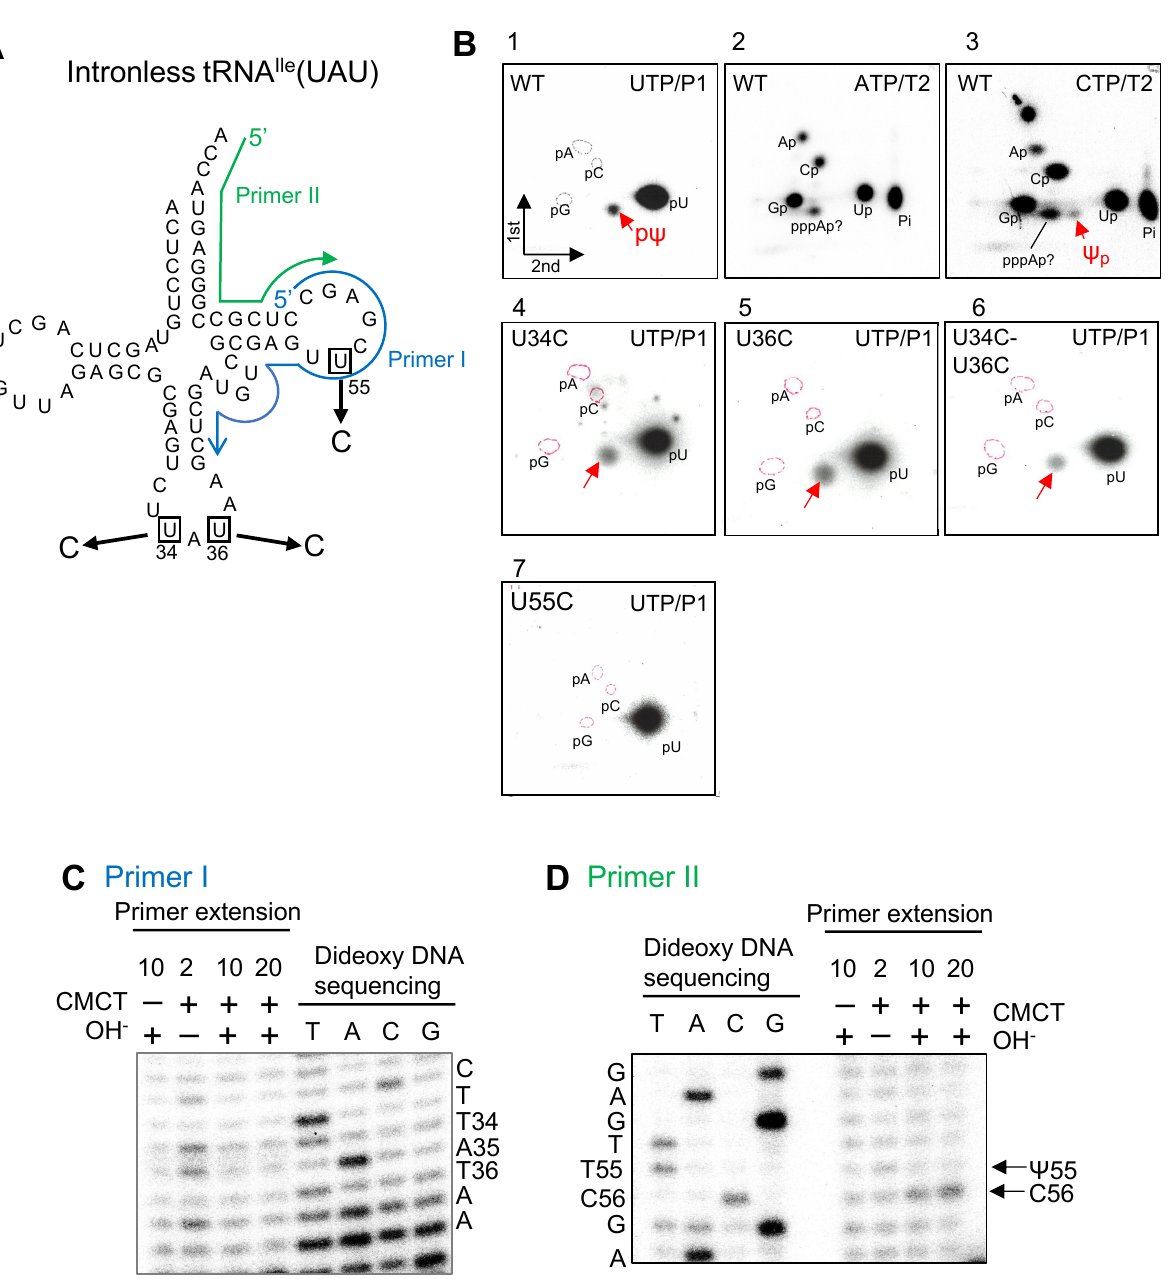
Figure 2. cmPus1 pseudouridylates the intronless tRNA Ile (UAU) transcript in vitro. ( A ) The clover- leaf structure of intronless tRNA Ile (UAU) of C. merolae is shown. Mutation positions are indicated by squares on the cloverleaf structure of intronless tRNA Ile (UAU) of C. merolae . The regions complemen- tary to the primers used for reverse transcription are marked as a blue arrow (primer I, position 60 to 40) and a green arrow (primer II, position 76 to 59) on the cloverleaf schematic. ( B ) UTP, CTP, and ATP refer to the 32 P-labeled nucleotide incorporated during the transcription reaction. The 32 P-internally labeled wild type (WT) or each mutant (U34C, U36C, U34C-U36C, or U55C) of the tRNA Ile (UAU) transcript was incubated with cmPus1, and then the RNA was digested by nuclease P1 (P1) or RNase T2 (T2). Ψ formation was analyzed by 2D-TLC. Spots derived from p Ψ and Ψ p are indicated by red arrows. Positions of standard markers (pA, pG, and pC) are enclosed by red dotted